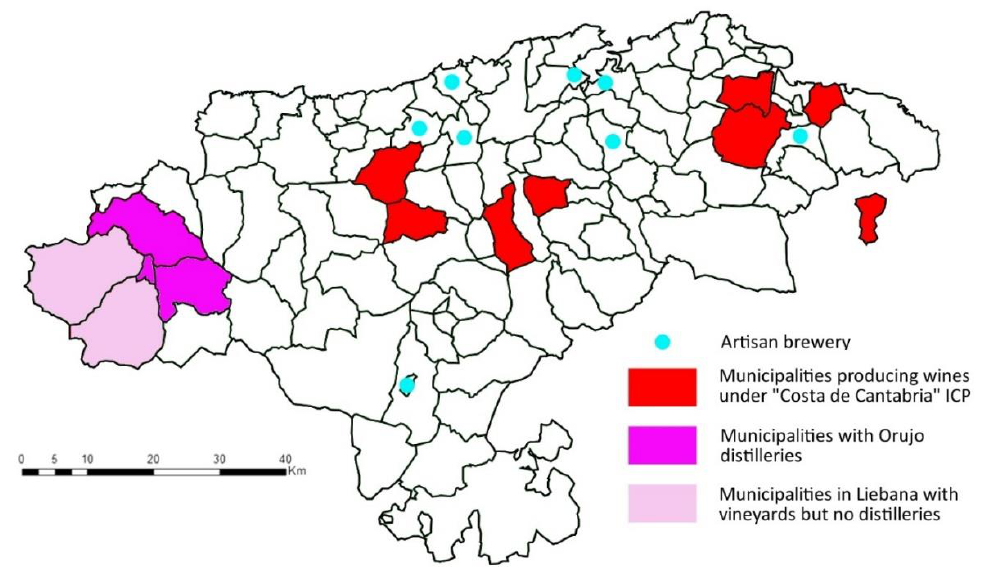
Figure 3. Location of the main by-product associated to the alcoholic beverage production generation areas in the region of Cantabria (Spain). Breweries and municipalities with vineyards and orujo